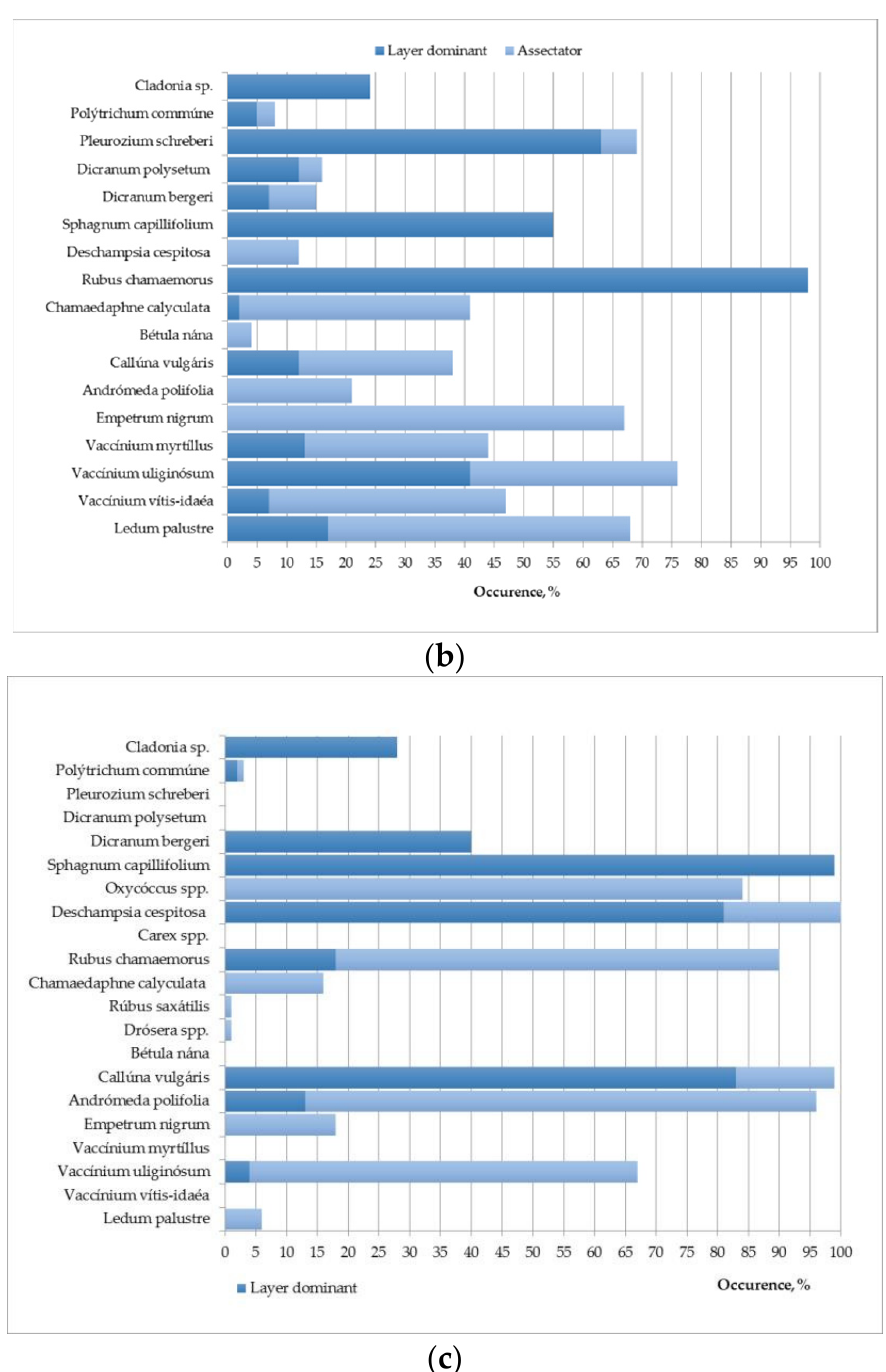
Figure 5. Average species diversity and occurrence of certain species of ground vegetation cover for: ( a ) undrained test sites; ( b ) effectively drained test sites; ( c ) rewetted test sites. On the effectively drained test site (D-1), the thickness of the peat deposit is from 80 to 150 cm. The upper layer of the deposit (0–35 cm) is composed of high-moor, undecomposed sphagnum peat (R = 2–5%). The 35–75 cm layer is composed of cotton grass–sphagnum high-moor peat with a decomposition rate of R = 15–20%. The bottom layer (75–150 cm) is formed by pine-cotton grass peat with a degree of decomposition R = 25–30%. The peat de- posit is dense. The groundwater level during the growing season varied within 15–30